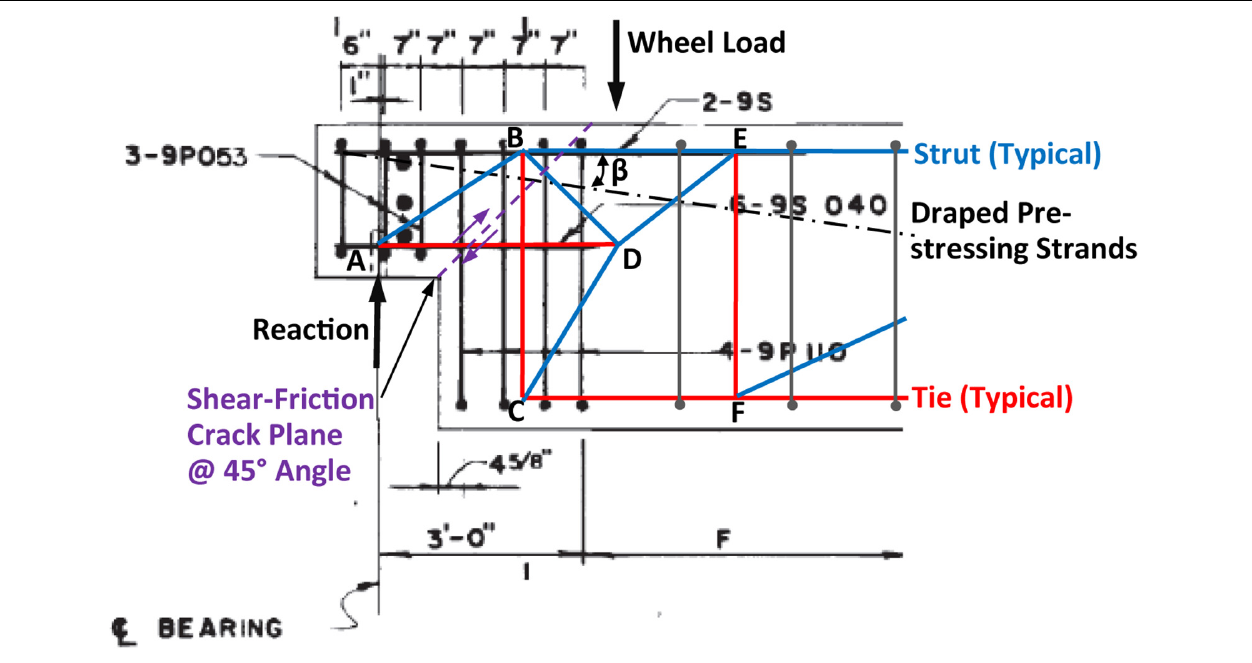
FIGURE 11 | Illustration of strut-and-tie modeling and shear-friction crack plane at dapped